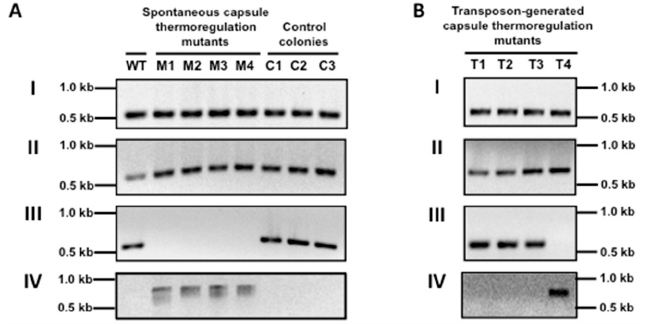
Figure 3. PCR assay to determine the presence of prophages on the chromosome of Streptococcus pyogenes strains. ( A ) Deletion of Φ HSC5.3 in spontaneous capsule thermoregulation mutants. Spontaneously generated capsule thermoregulation mutants producing a large amount of the capsule regardless of incubation temperature were screened after passaging the background strain CovRIFD in THY medium. Control colonies still displaying capsule thermoregulation on the same plates were also selected for this assay. PCR was performed to determine the presence of prophages using the primers to amplify a portion of a gene in Φ HSC5.1 (I), Φ HSC5.2 (II), or Φ HSC5.3 (III), or primers that amplify HSC5 chromosomal DNA only when Φ HSC5.3 was cured (IV). Strains used: WT (wild-type), HSC5; M1–M4 (mutant strains), randomly chosen four spontaneously arisen capsule thermoregulation-negative mutants; C1–C3 (control strains), colonies still showing capsule thermoregulation after passaging; ( B ) The existence of Φ HSC5.3 in the transposon-generated mutants. Since the excision of Φ HSC5.3 occurs spontaneously and influences capsule thermoregulation, the presence of Φ HSC5.3 in the previous transposon-generated mutants was determined through PCR. The same primers were used as those used in Figure. A. Strains used: T1–T4 (transposon-generated capsule thermoregulation mutants), a transposon insertion occurred in the gene L897_07695 in Φ HSC5.3 (T1), at or near the ribosome binding site of cvfA (T2 and T3, previously described as CovRIFD:TnCvfA1 and CovRIFD:TnCvfA2, respectively [10]), or in the intergenic region (IGR) immediately upstream of the capsule operon